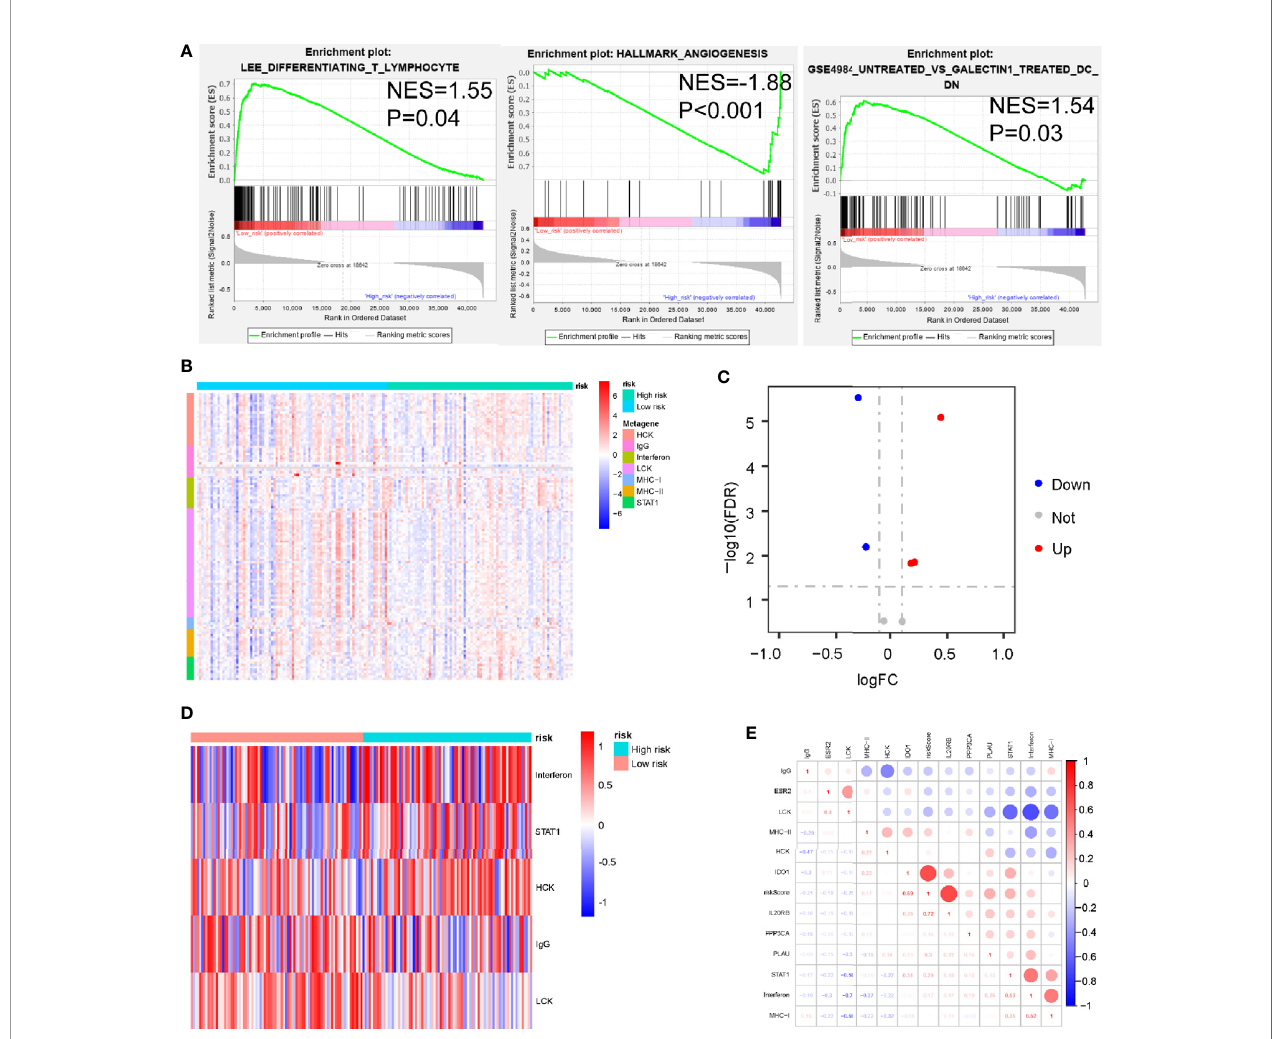
FIGURE 5 | Associations between prognosis-associated immune signature (PAIS) and immune response in pancreatic ductal adenocarcinoma (PDAC). (A) Signi fi cant enrichment of immune pathways between the high-set and low-risk sets. NES: normalized enrichment score. (B) Heatmap of relationships between PAISs and seven clusters of in fl ammatory metagenes. (C) Volcano plot of four clusters of in fl ammatory metagenes differentially enriched in the high- and low-risk sets. (D) Heatmap of fi ve clusters of in fl ammatory metagenes differentially enriched in the high- and low-risk sets. (E) Crosscorrelogram derived based on Pearson ’ s correlation coef fi cient values between PAISs and seven clusters of in fl ammatory